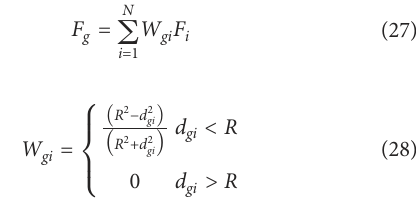
TABLE 1 The symbols in the external mode of the Princeton Ocean Model with the generalized coordinate system.